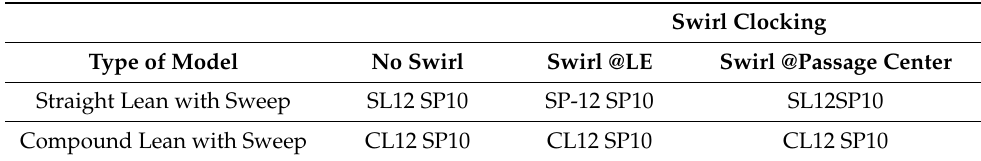
Table 4. Highest stage performance models at proposed swirl clocking.